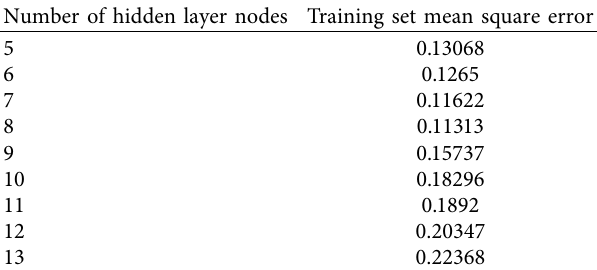
Table 6: Implicit node selection calculation.